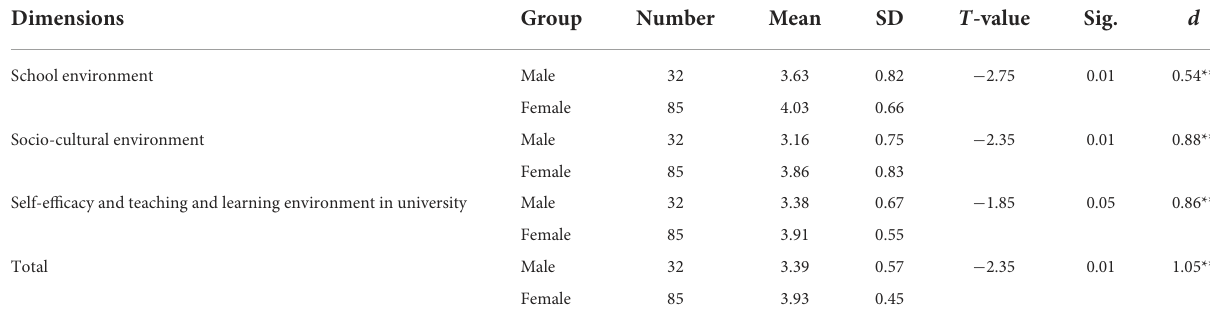
TABLE 3 The significance of the differences between male and female students on the scale dimensions as well as on the total score.